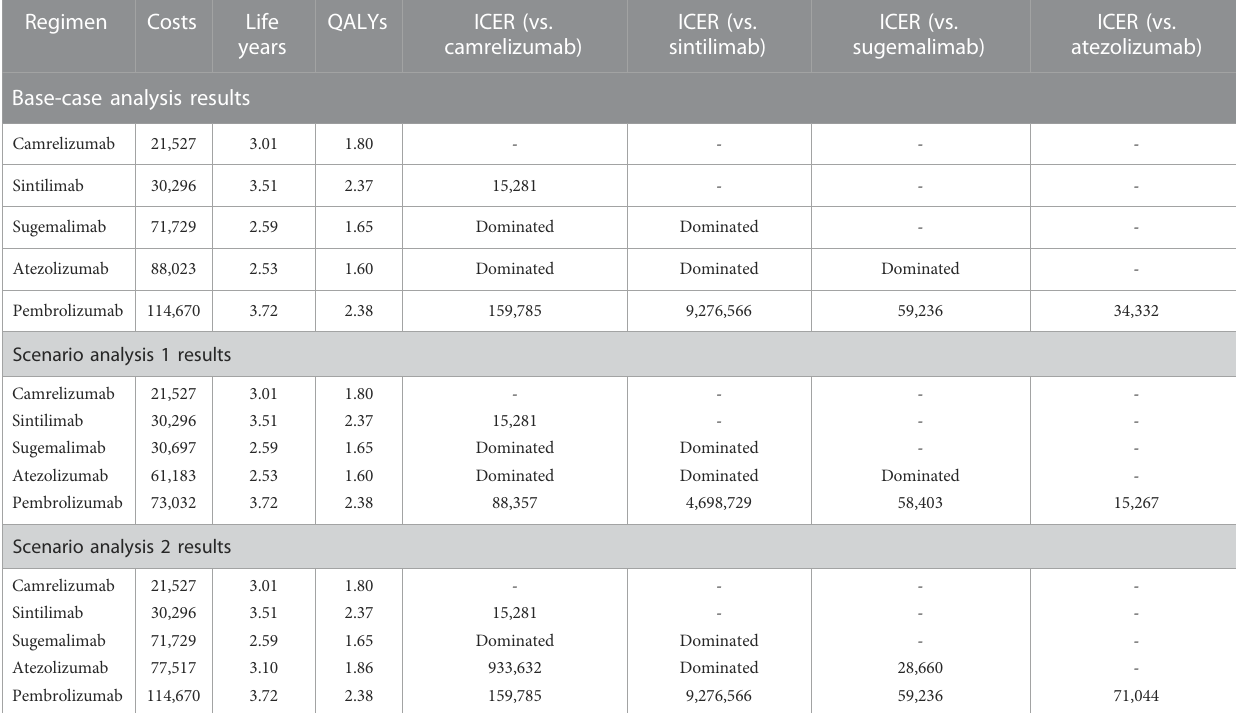
TABLE 2 Base-case analysis and scenario analysis